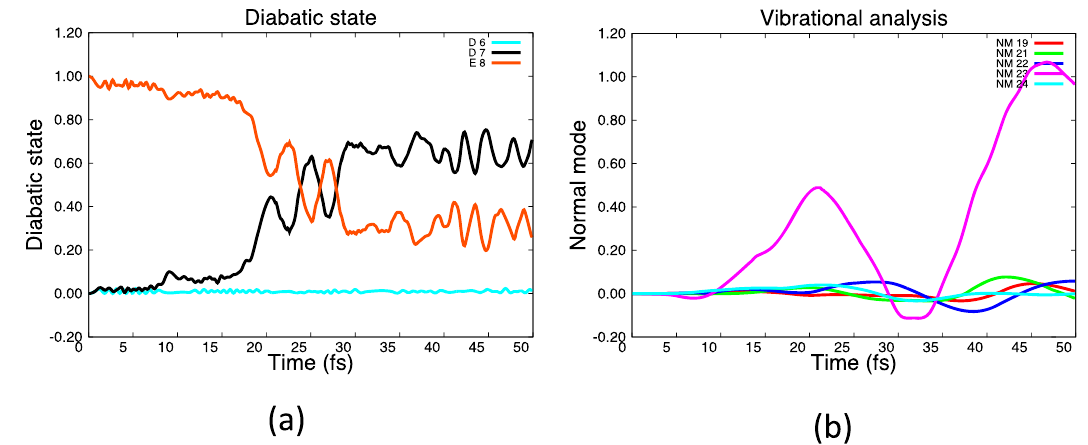
Fig. 5 Decay of state E at an E/D conical intersection at 10 – 20 fs with the stimulation of mode 23 (see Table 1). Note that D 7 is populated fi rst while D 6 begins to become populated only after 75 – 85 fs (not shown). a Electron dynamics (diabatic populations). b Normal mode populations (weighted by